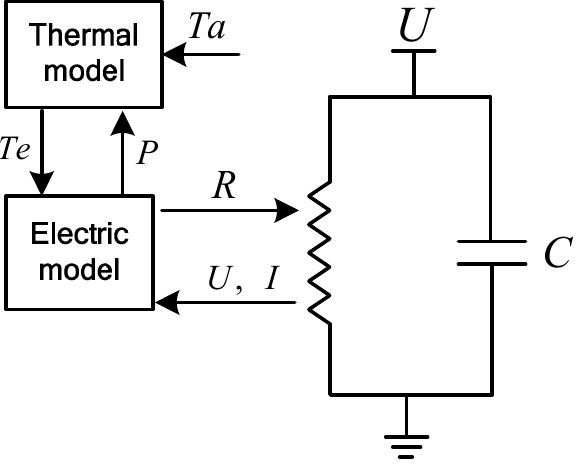
Figure 2. Diagram of the electrothermal MOA model.